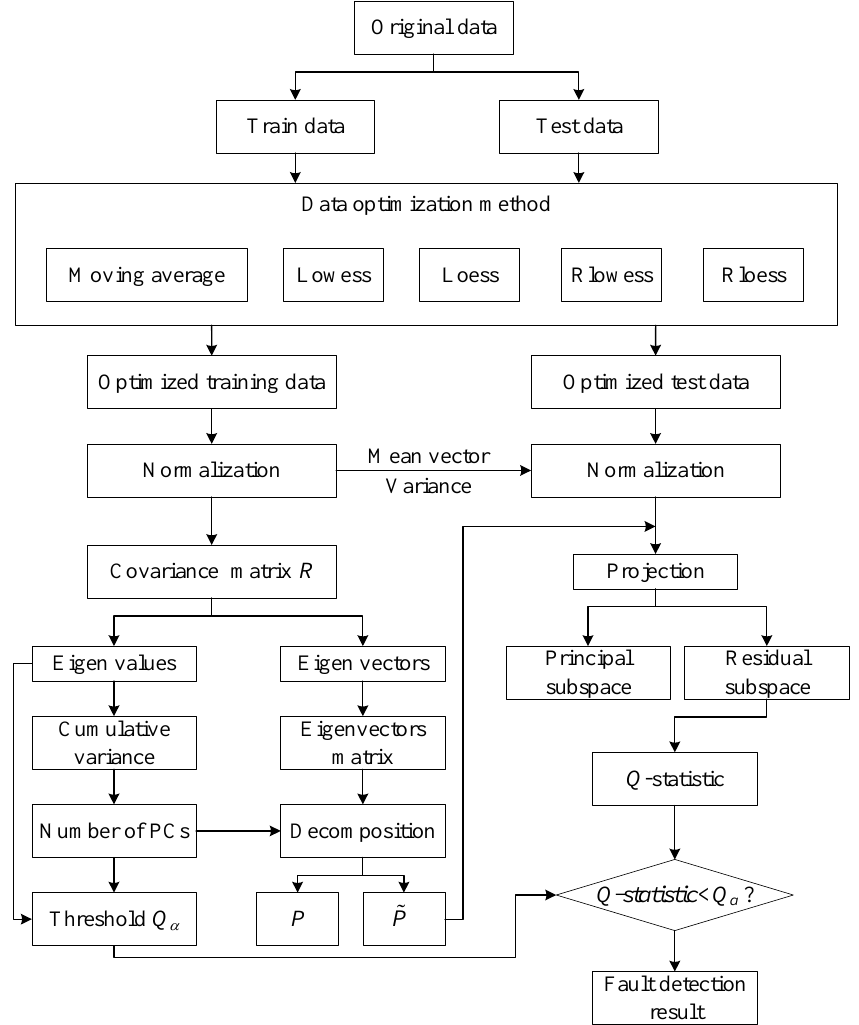
Figure 1. Schematic diagram of principal component analysis fault detection strategy optimized using multiple data smoothing methods. using multiple data smoothing